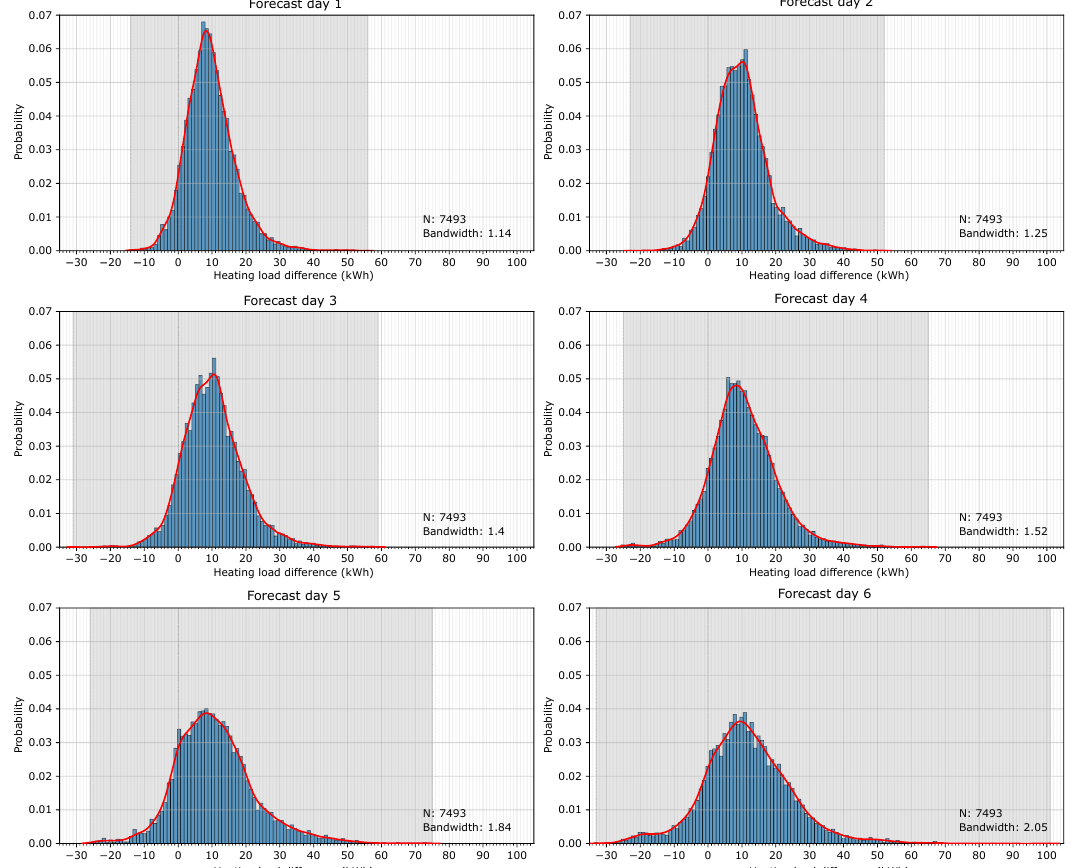
Figure 6. Probability histogram of the 6 forecast days and the Gaussian kernel density estimation (red line).